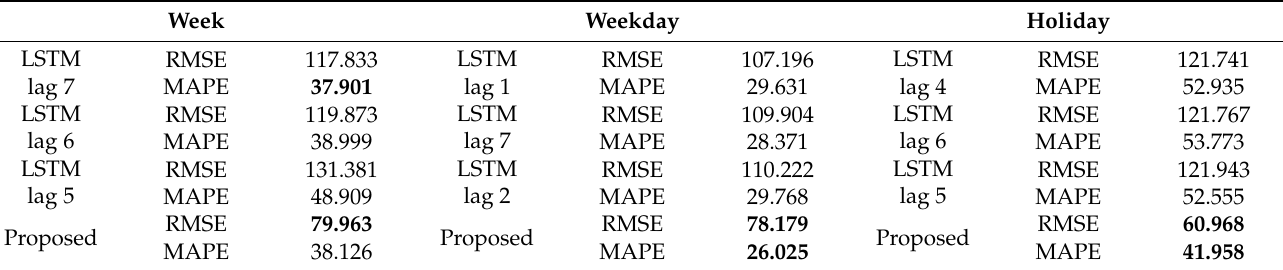
Table 8. Results of proposed model for Route 52 based on minimal